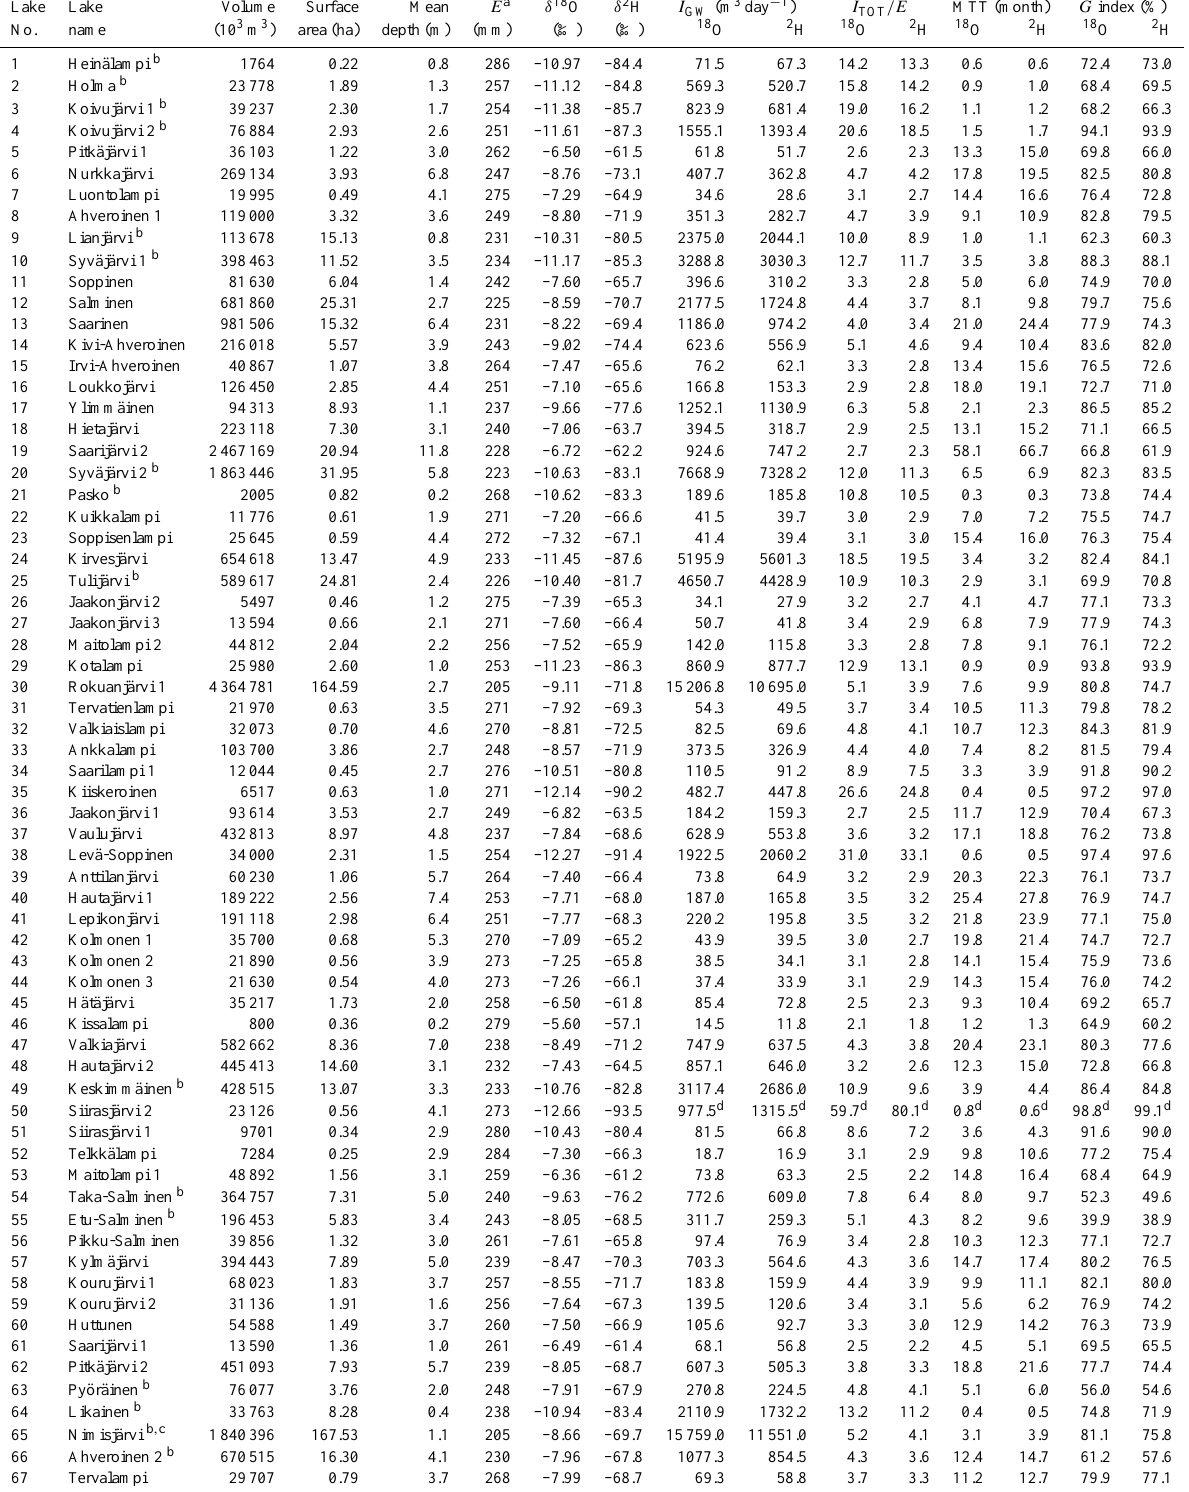
Table 2. The results of isotope mass balance calculations for 67 lakes of Rokua esker sampled during the July–August 2013 field survey. Lake